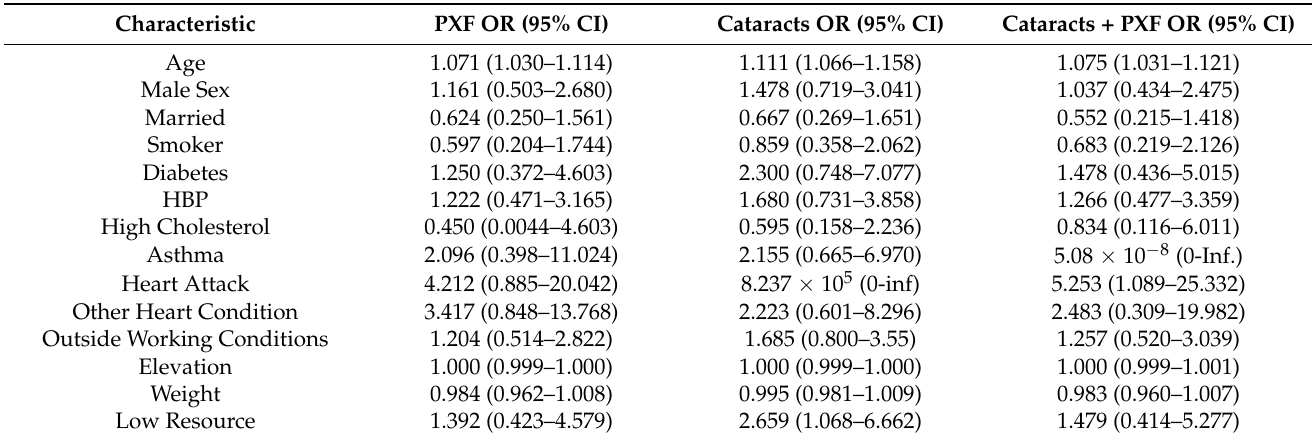
Table 4. Univariate analysis of epidemiological risk factors and eye